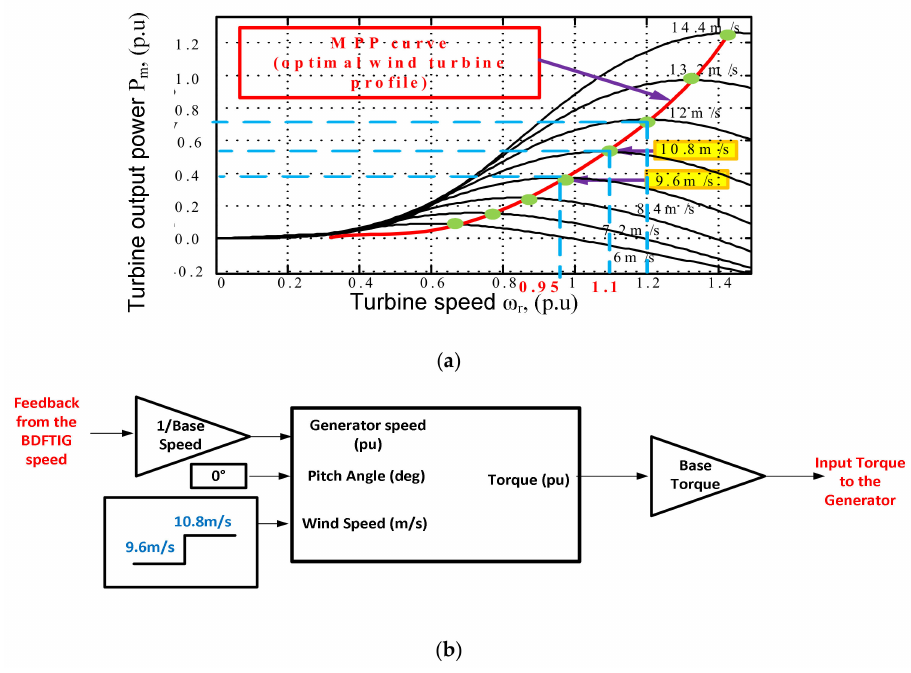
Figure 7. Simulated wind turbine: ( a ) output power versus generator speed at di ff erent wind speeds, at β = 0, and ( b ) turbine simulation model